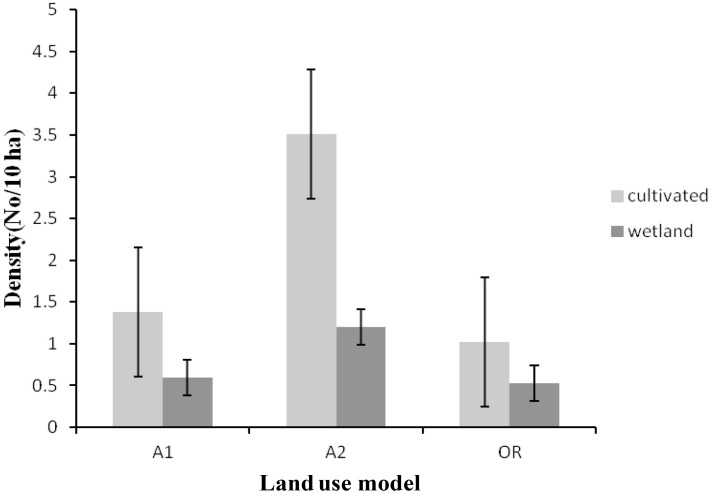
Densities of Wattled Crane for each land-use category in 2012.Where A1 = the self contained small scale commercial farms of 30 to 40 ha per household, A2 = large scale commercial agriculture farms of > 50 ha per household and OR = Old Resettlement, villagized agriculture farms of < 5 ha per household with communal grazing land. Error bars indicate level of error margin (±0.05) or uncertainty of population densities recorded in this study.